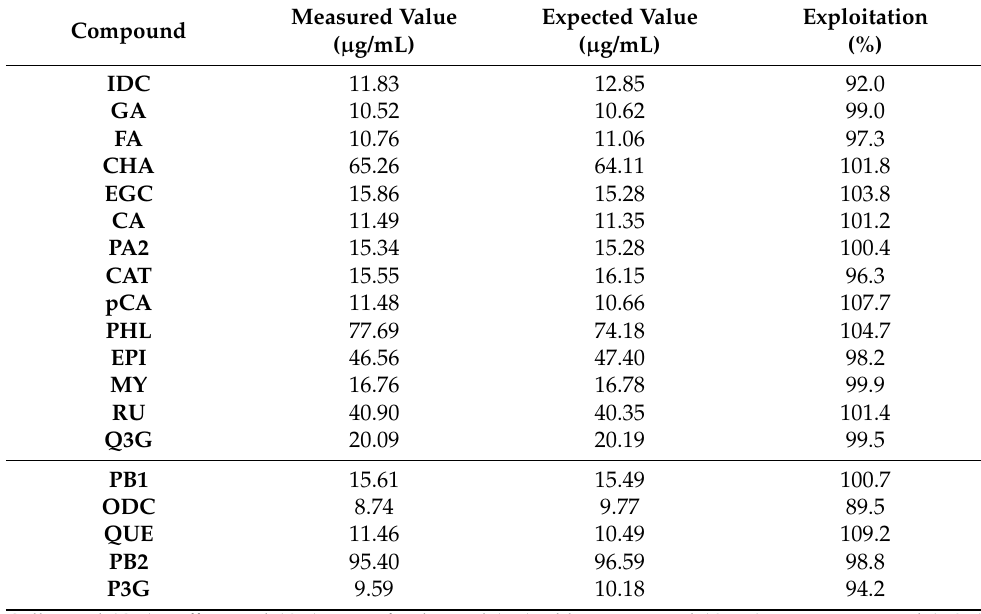
Table A6. Accuracy and the trueness of HPLC method for the detection of apple